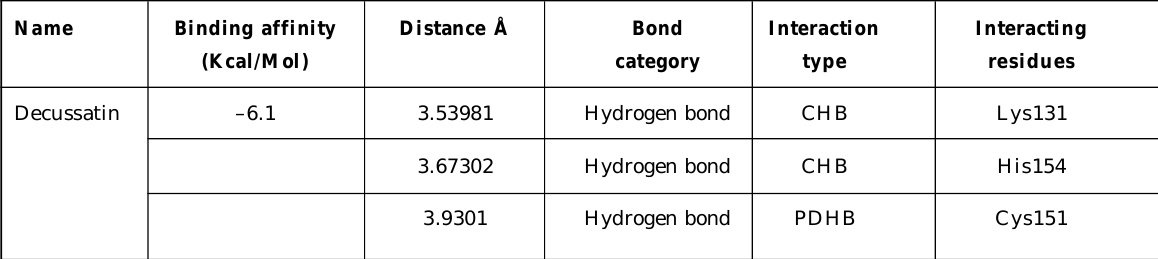
Table 4: Post dock interaction profile obtained from Accelrys Discovery Studio for the ligands-BTB domain